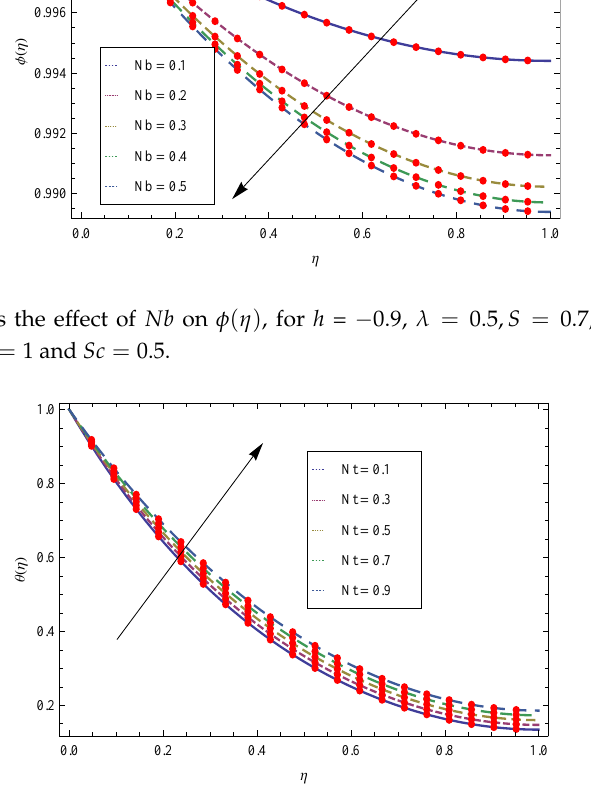
Figure 21. The effect of Nt on θ ( η ) , when h = − 0.5, λ = 0.7, S = 0.7,kr = 0.7,Pr = 30,Ec = 0.7, Nb = 0.5, β = 1, and Sc =